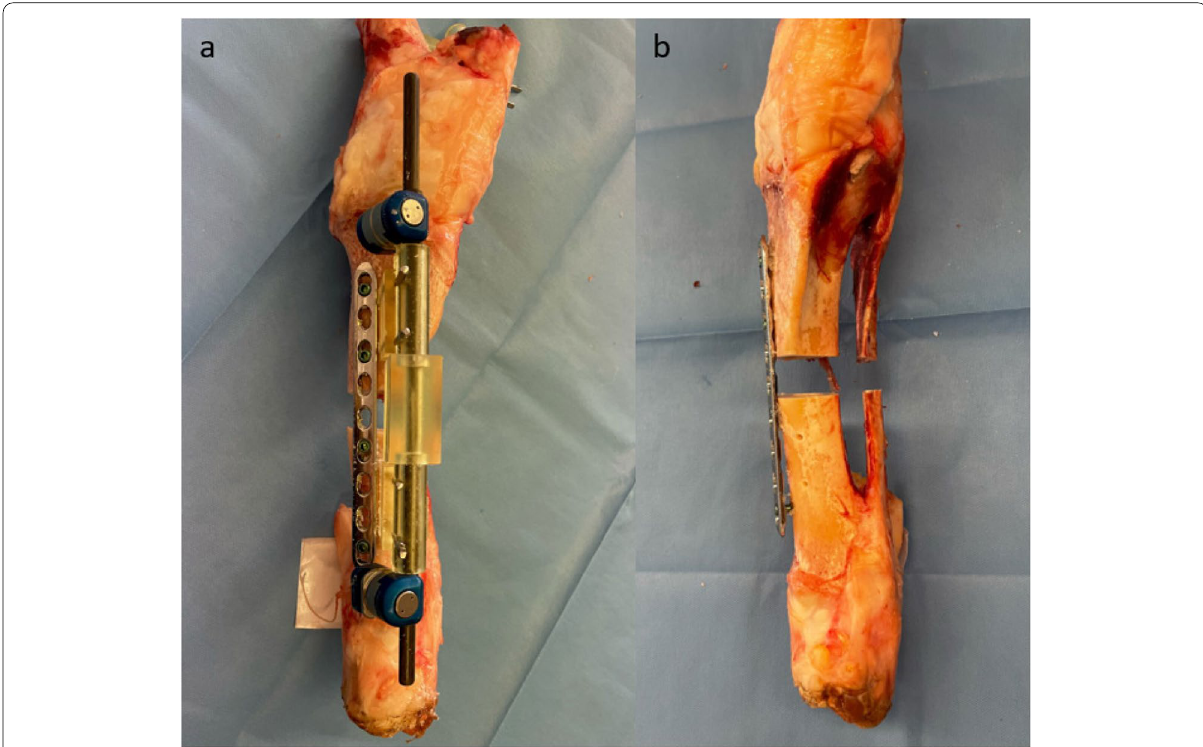
Fig. 6 Tibial surgical site after reduction and plate fixation. a shows the anteromedial view after plate fixation with the reduction guides and bridging carbon fiber rods still in place. b shows final result with the reduction guides and pins removed in the frontal